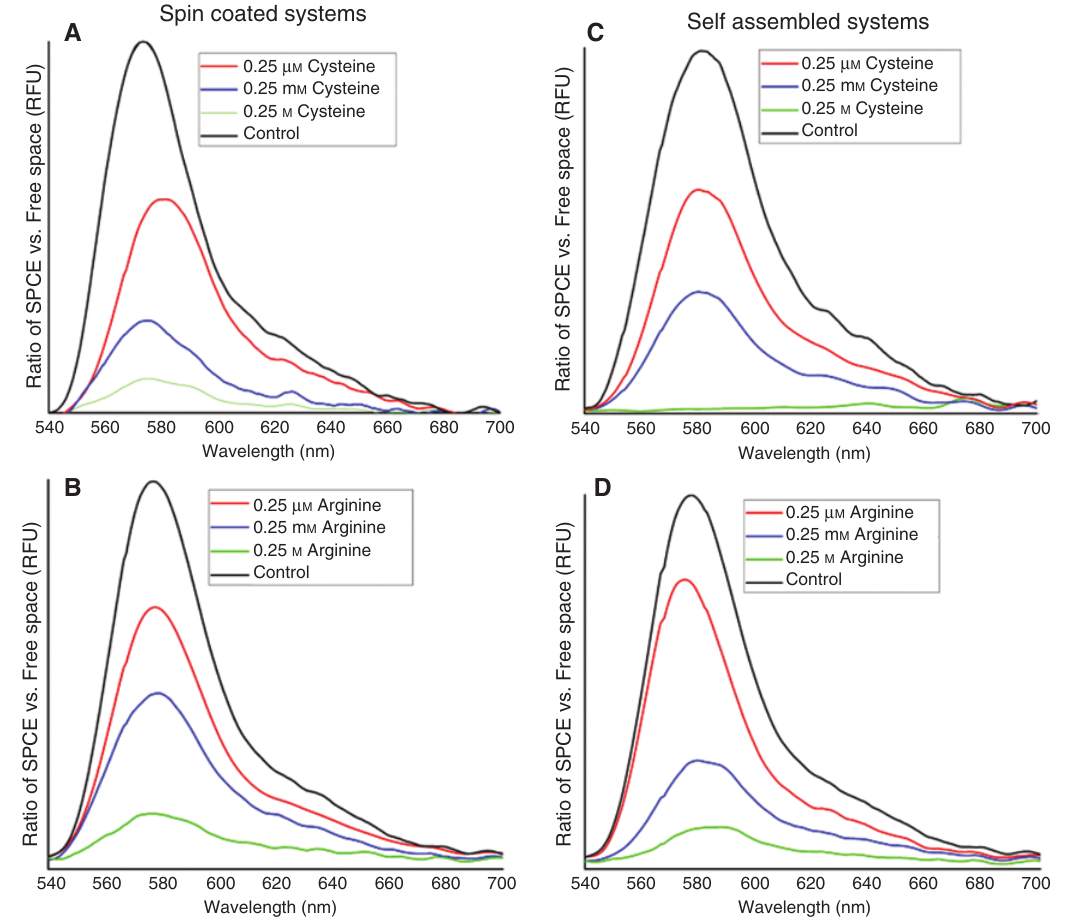
Figure 2: Plot depicting variation of SPCE signal intensity with varying amino acid concentrations. (A) Spin-coated Cys/Ag system. (B) Spin-coated Arg/Ag system. (C) Self-assembled Cys/Ag system. (D) Self-assembled Arg/Ag system.